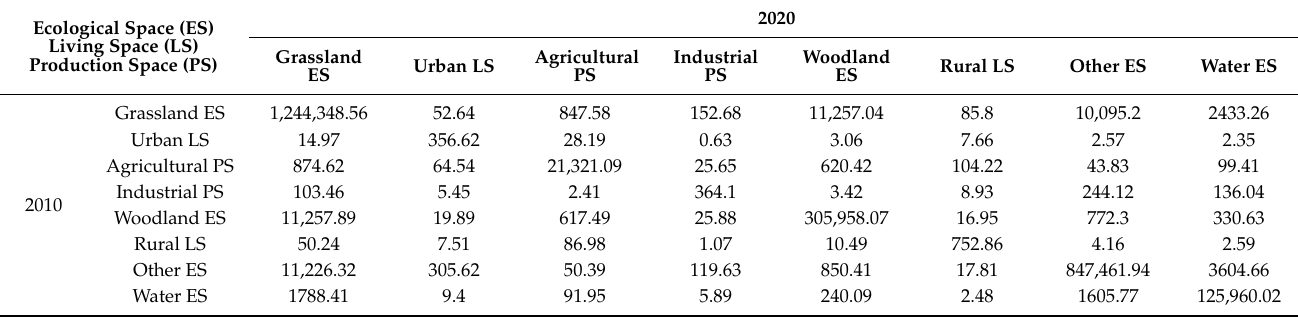
Table A4. Transfer matrix of land use structure change from 2010 to 2020 (km 2